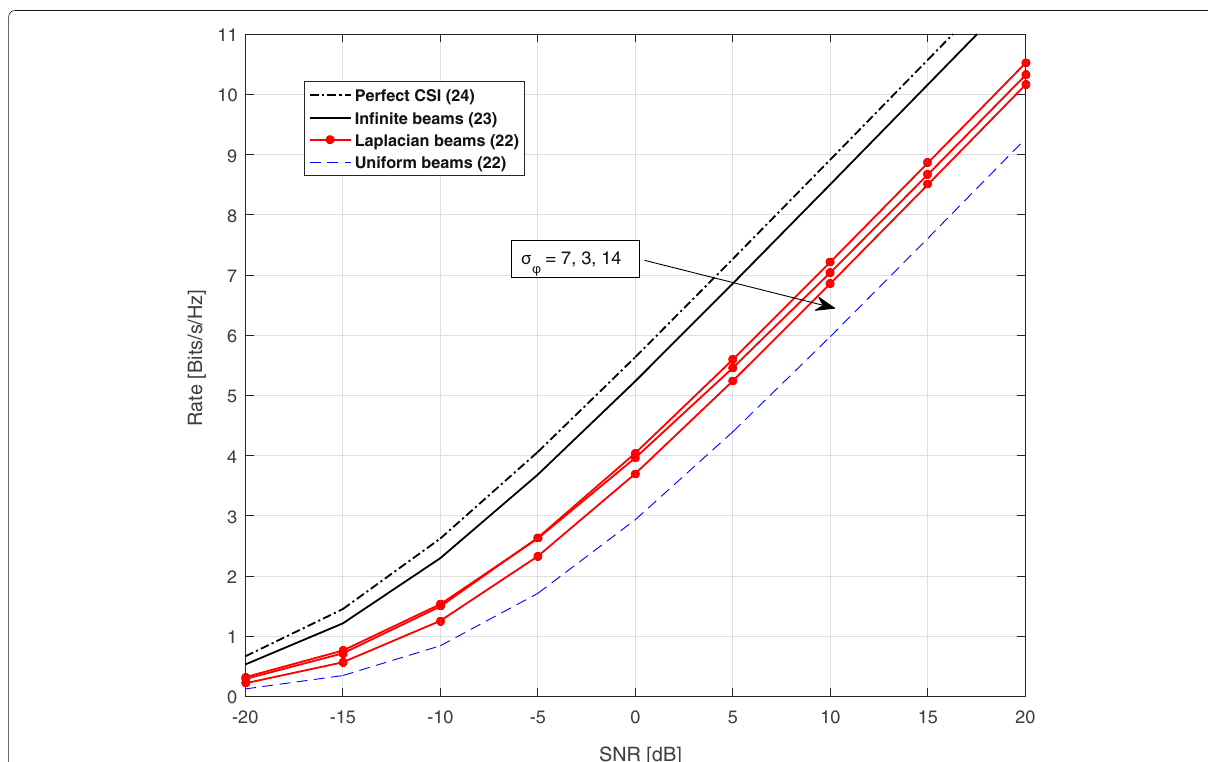
Fig. 5 Spectral efficiency achieved by Laplacian beam codebooks compared to uniform beam codebooks with M = 8 beams. The Laplacian beams are designed for standard deviations σ φ = 3 ◦ ,7 ◦ , and 14 ◦ for a channel with N p = 2 and σ φ = 7